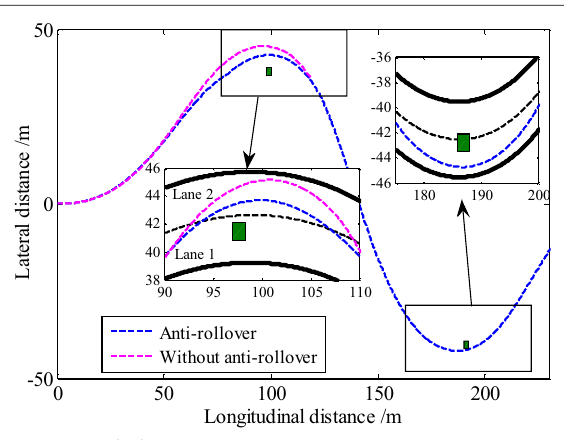
Figure 14 Vehicle’s trajectories in Scenario